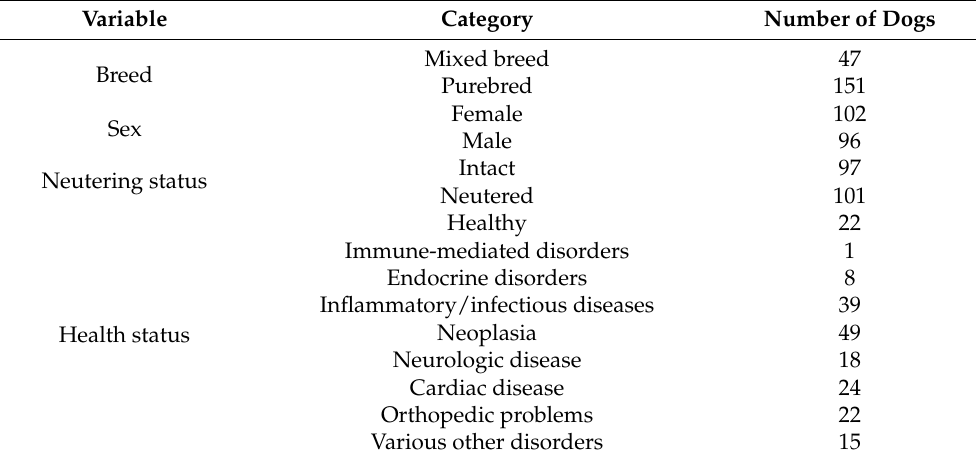
Table 2. Signalment and health status of the client-owned